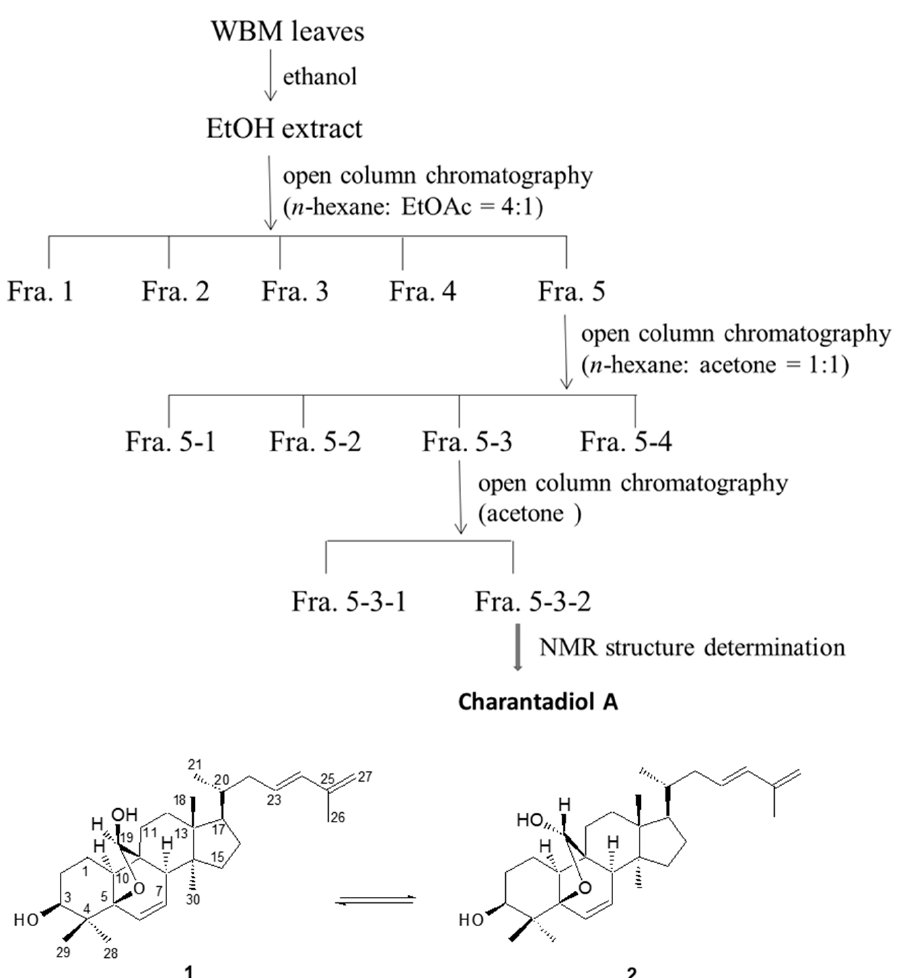
Figure 1. Schemes of the extraction and isolation of charantadiol A. Due to the C-19 hemiacetal carbon in charantadiol A ( 1 ), its 19( S ) epimer ( 2 ) was also found as impurity in the NMR spectra. To determine whether Fra. 5-3 would affect cell viability, THP-1 cells were incubated firstly in culture medium supplemented with various concentrations of tested samples.